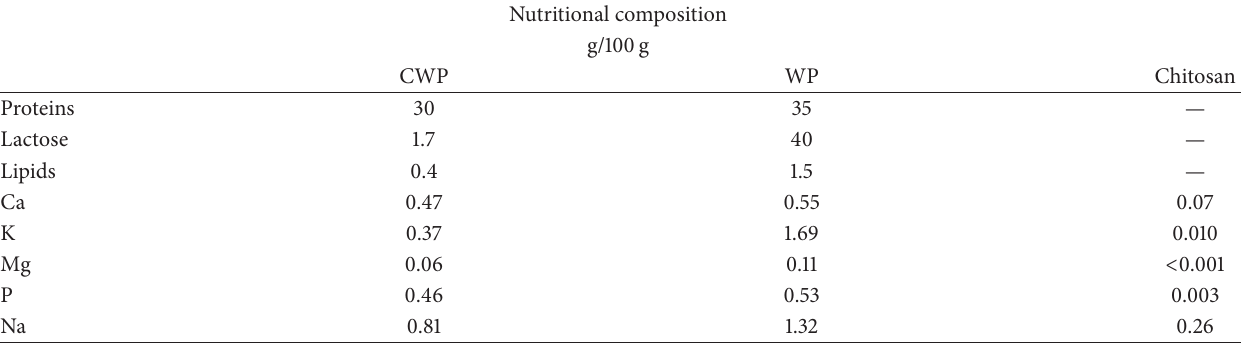
Table 2: Partial composition of micronutrients by ICP and chemical macronutrients of CWP, WP, and Chitosan. Nutritional